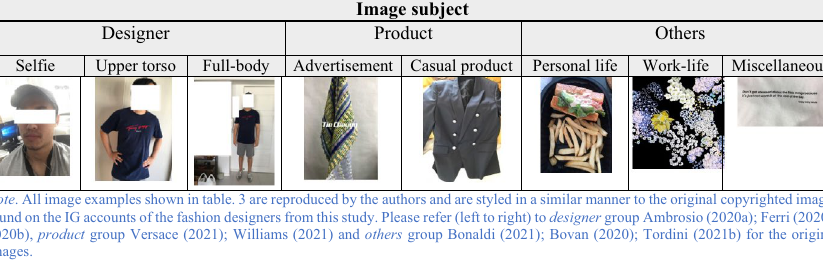
Table 3 Image identification